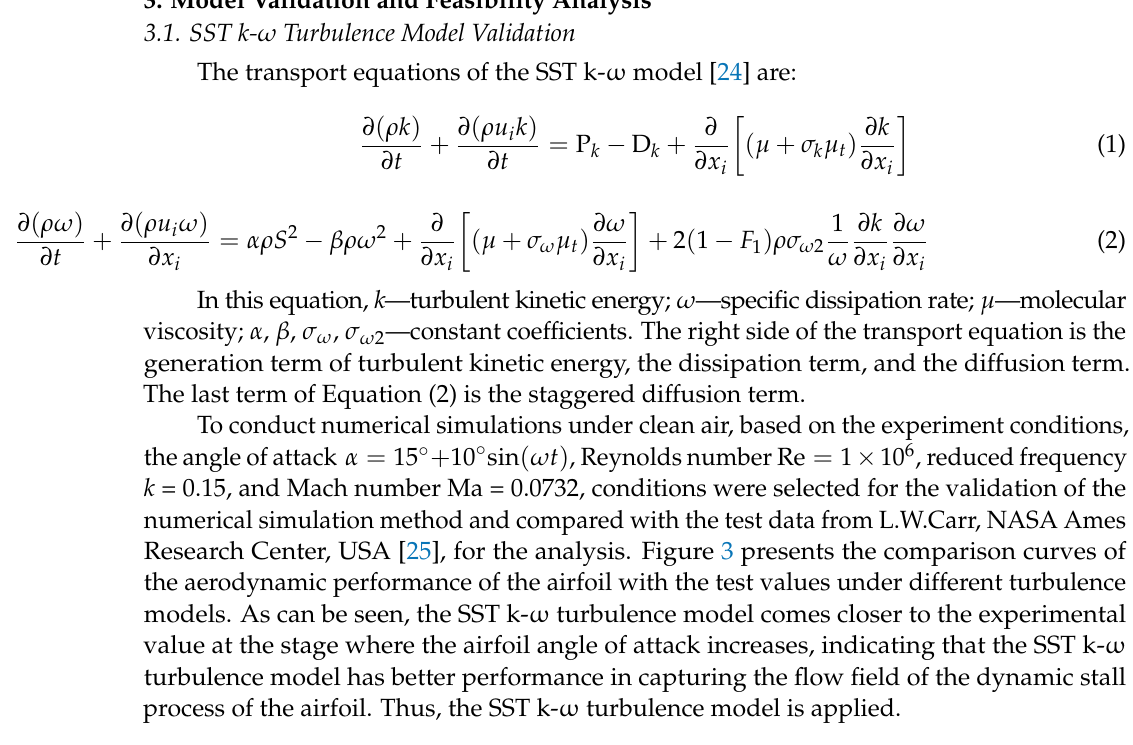
Figure 2. Airfoil computational domain and slip mesh interface.